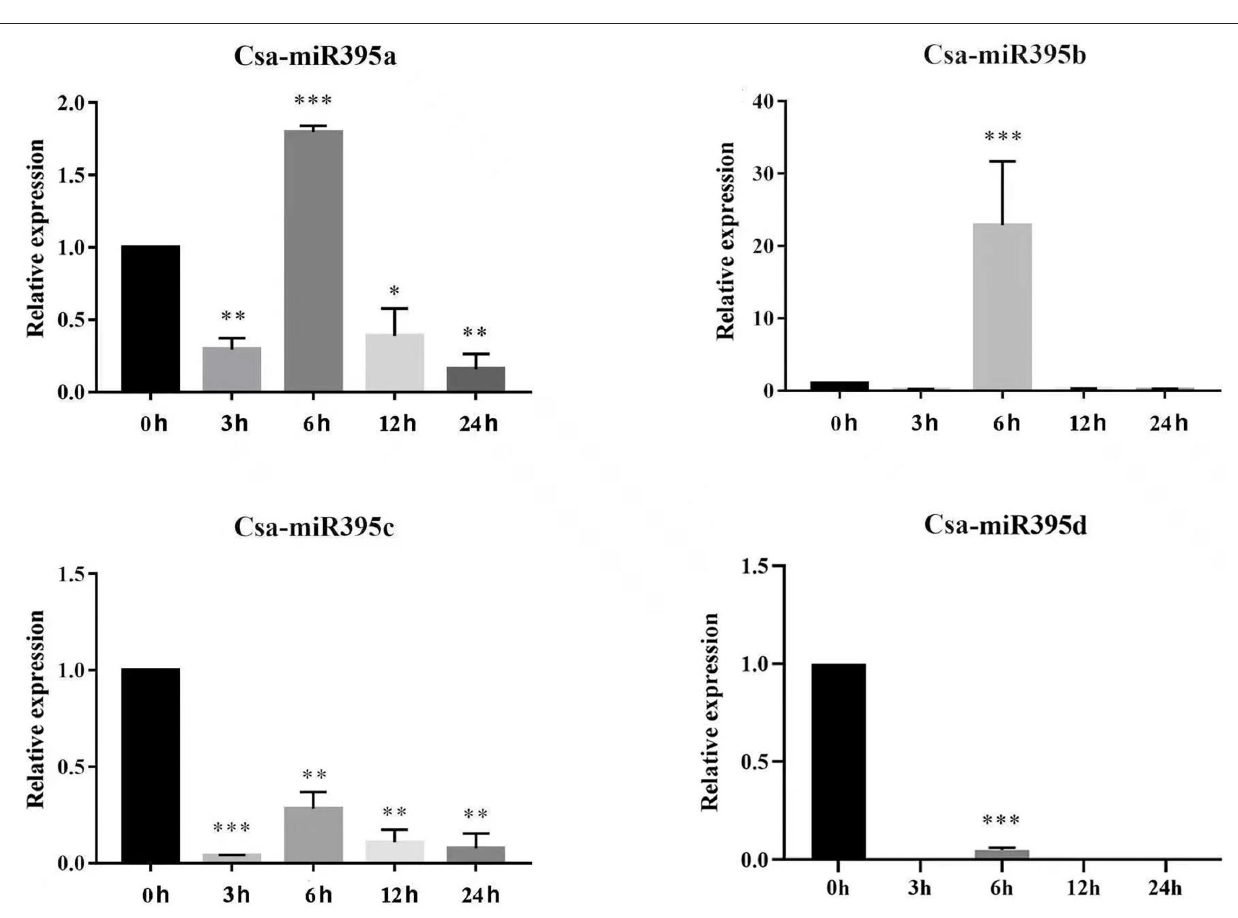
FIGURE 8 | Expression levels of Csa-miR395s in response to NaCl stress (0, 3, 6, 12, and 24h). The X-axis represents the hours of 150 mmol/L NaCl treatment. The Y-axis represents the relative expression level of a transcription factor. The values represent the means ± SDs. The significant difference is represented by asterisks according to t -test (* p < 0.05, ** p < 0.01, and *** p <